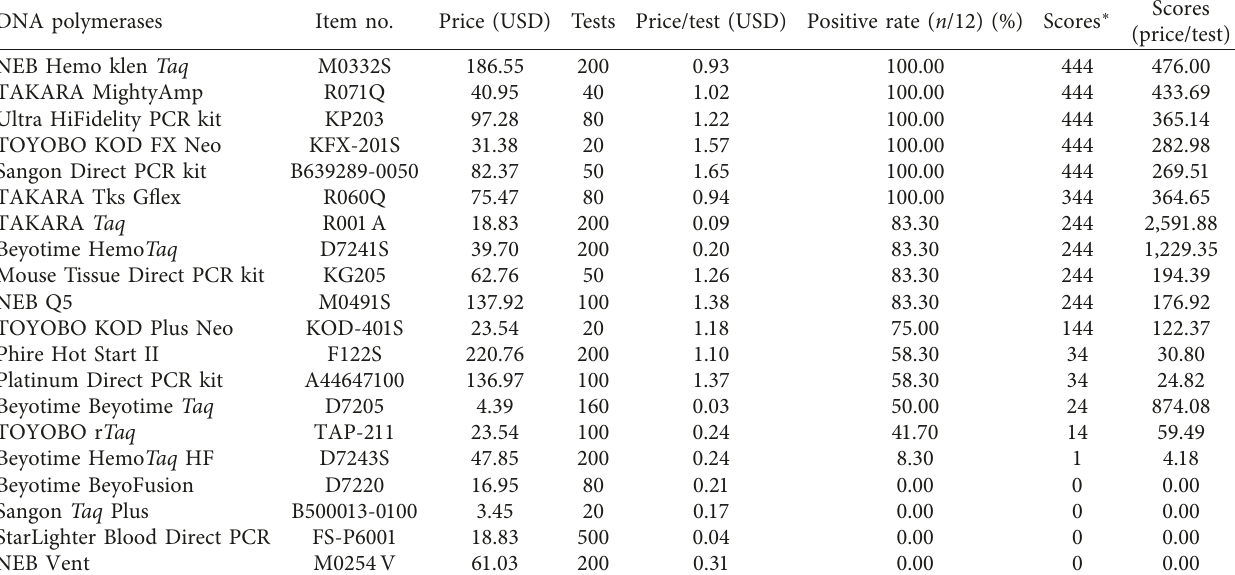
Table 3: Cost-effectiveness comparison of 20 DNA polymerases. DNA